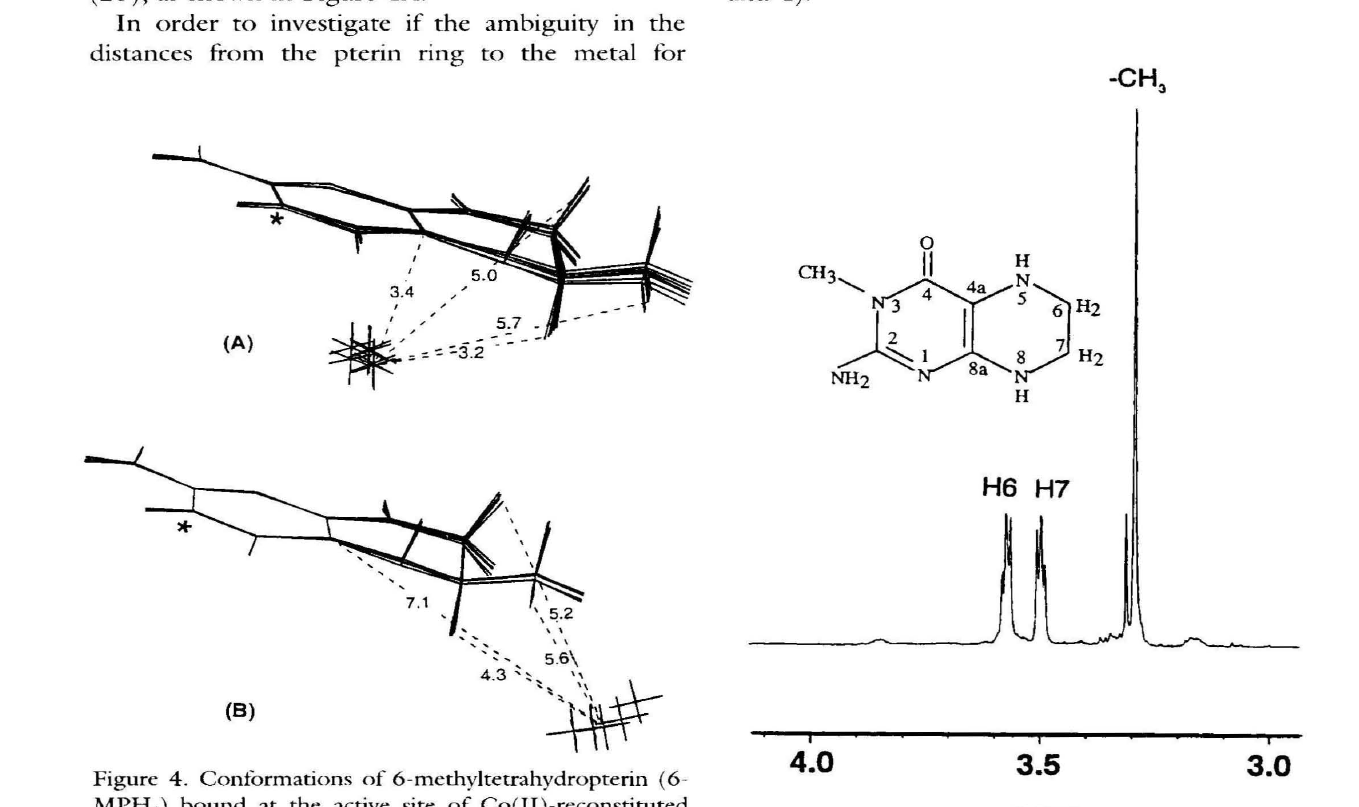
Figure 4. Contormations of 6-methyltetrahydropterin (6- MPH bound at the active site of Co(II)-reconstituted 4 ) THI based on the experimental distances measured in ref 16. Family A (A) and family B (B), shorter and long er distance from the pteridin ring to the metal ion, respectively (see Results and Discussion), with equatorial position for the methyl group at C6. For one conformer in each family, the distances in A to the metal are shown. The asterisk shows the position of the N3. Pteridines/ Vol. 9/ No. 1